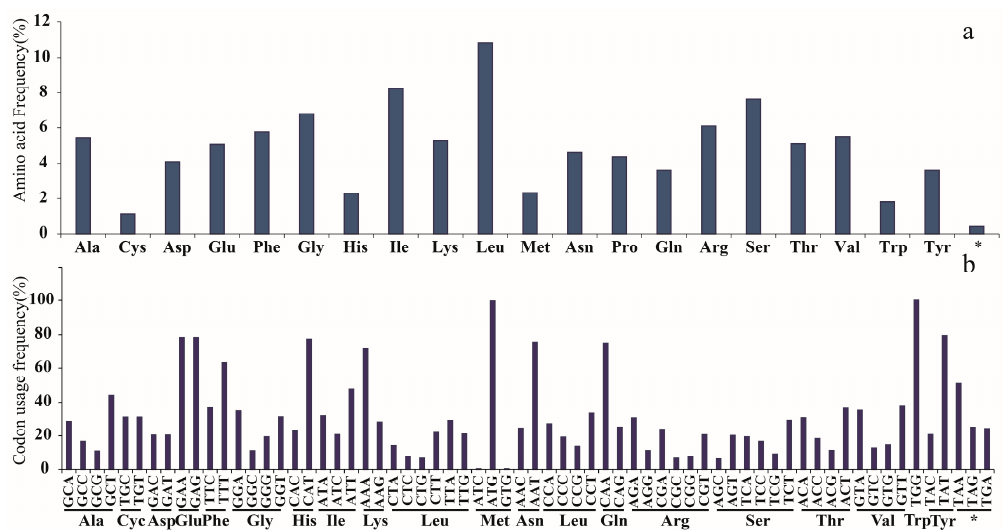
Figure 2. Amino acid ( a ) and codon usage ( b ) frequencies of the protein-coding sequences in the seven Lonicera chloroplast genomes. *: Termination codon. Table 2. List of genes present in the chloroplast genomes of seven Lonicera species. Gene